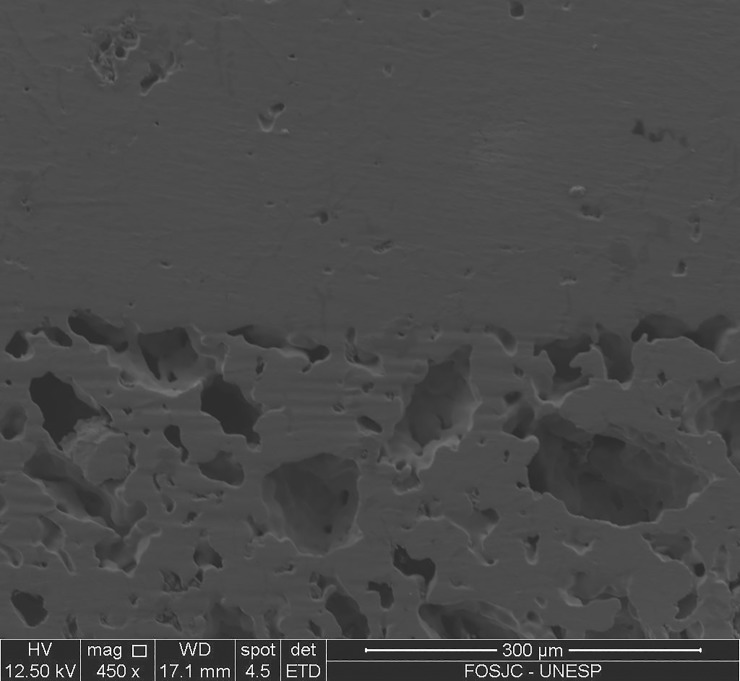
Scanning electron micrograph of a longitudinal section.a) implant with porous surface integrated with a dense core; b) detail of pores interconnected.